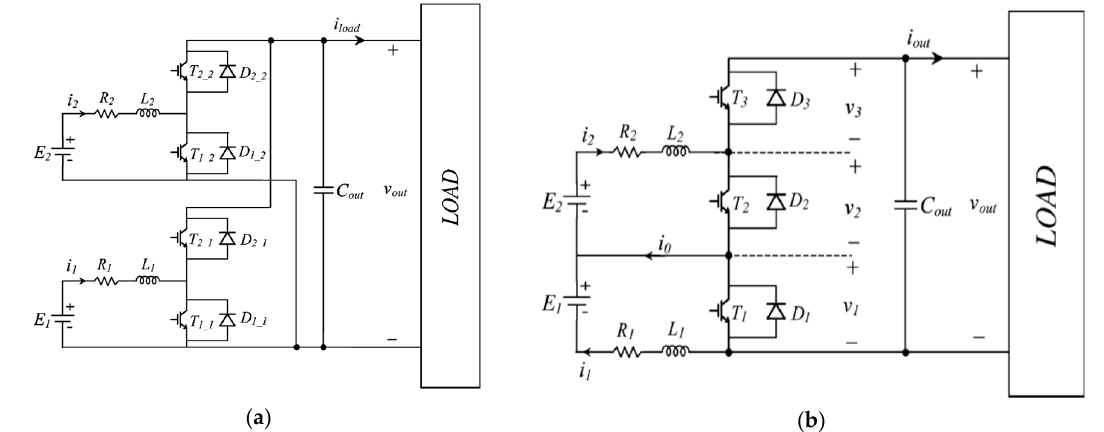
Figure 1. ( a ) 4SC architecture ( b ) 3SC architecture.